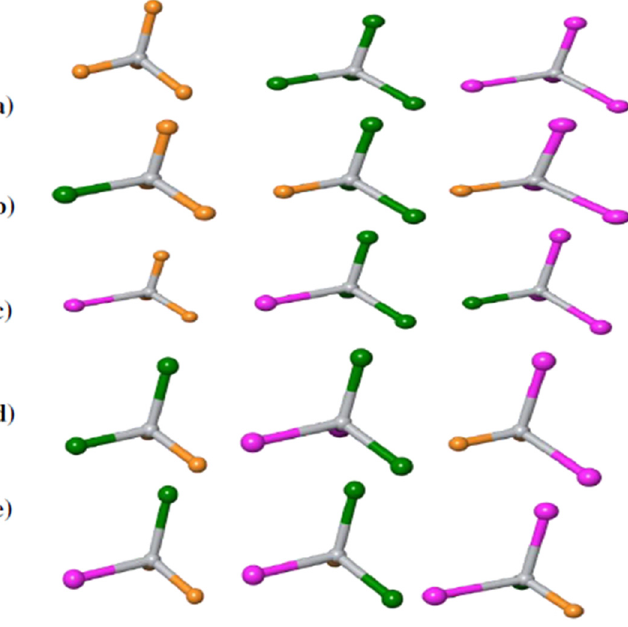
Figure 11: Schrödinger suite computed precursors ( heteroleptic and homoleptic ) when three halide ( fl uorine, chlorine, and iodine ) ligands are united around tetravalent titanium metal centre ( colour grey represents titanium, orange is fl uorine, green is chlorine, and magenta is iodine ) [ 128 ]